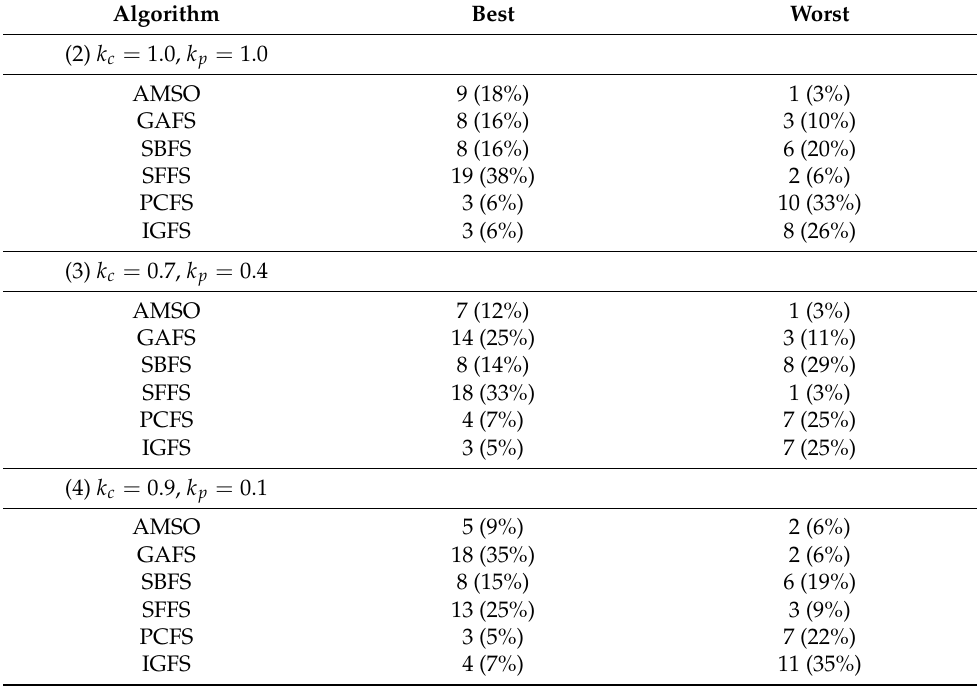
Table 11. Sensitivity of performance complementarity to objective function